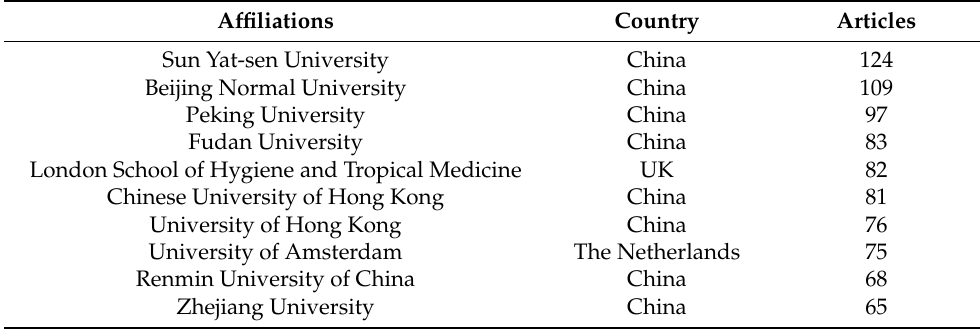
Table 4. Top 10 institutions in the field of rural-to-urban migrants (1 January 2004–3 June